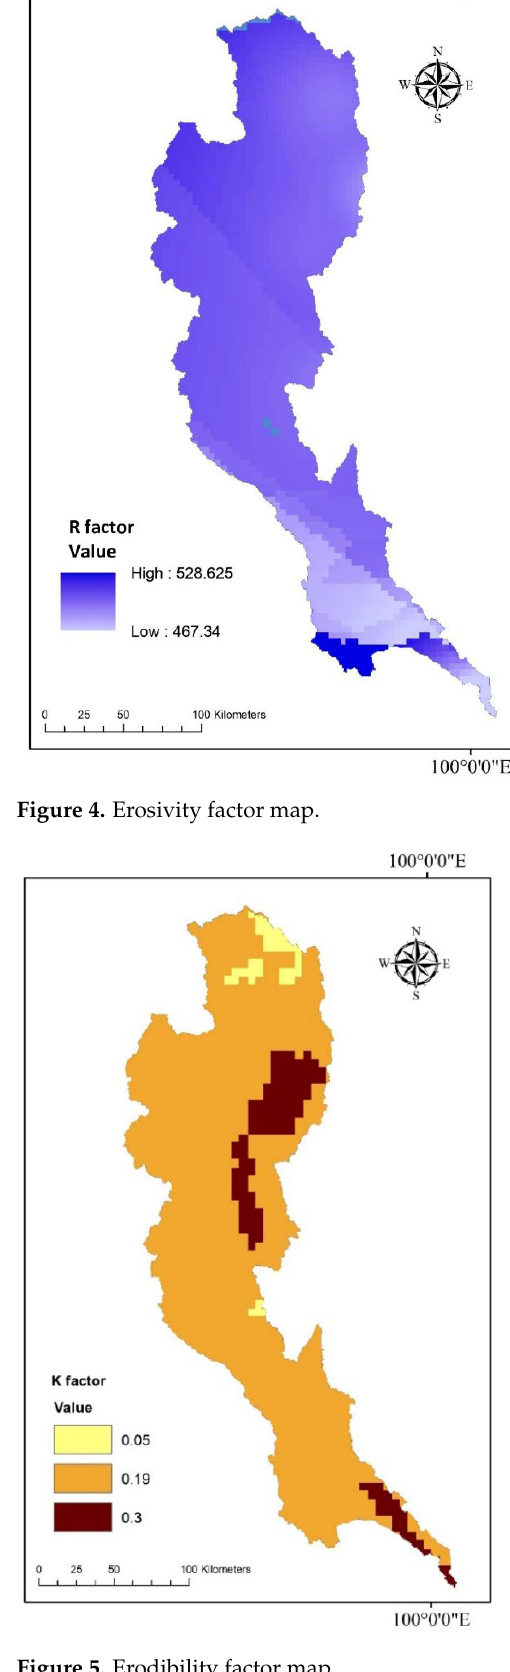
Figure 6. Topographic factor map.